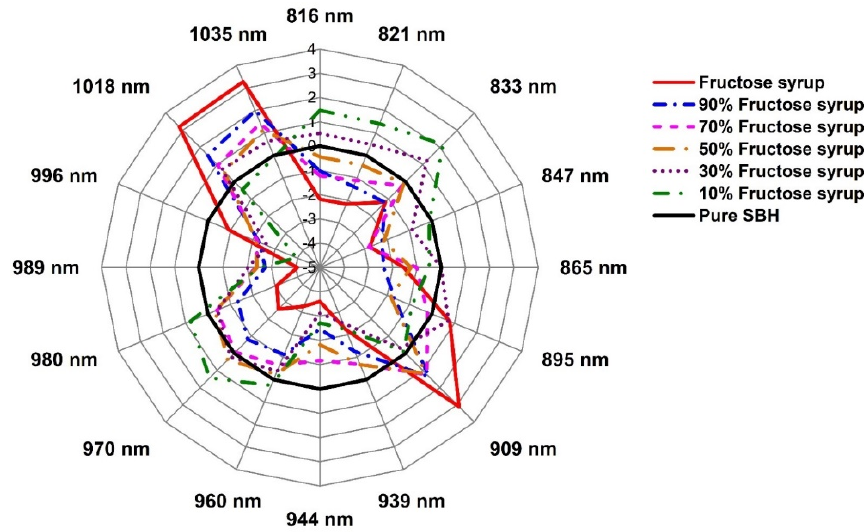
Figure 10. Aquagrams of pure SBH, fructose syrup, and adulterated SBH with various percentages of fructose syrup.